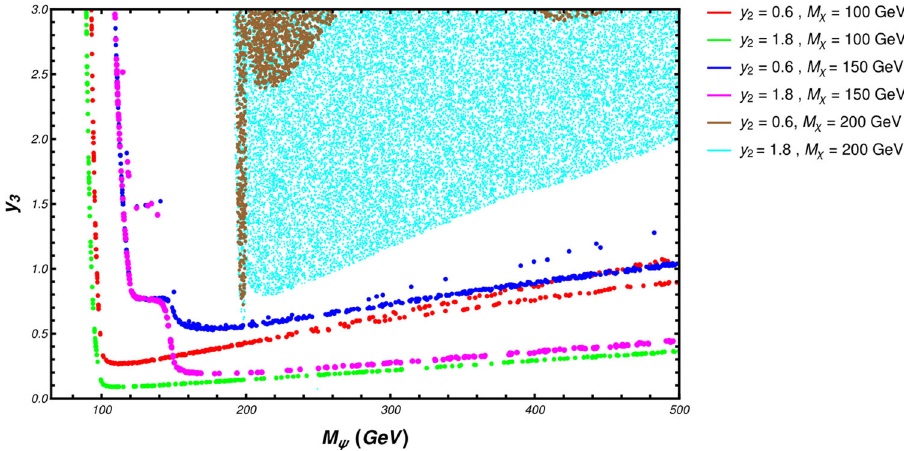
Fig. 8 Regions of y 3 − M ψ plane compatible with (cid:13) tot h 2 satisfying the experimental bounds, for specific values of y 2 and M χ